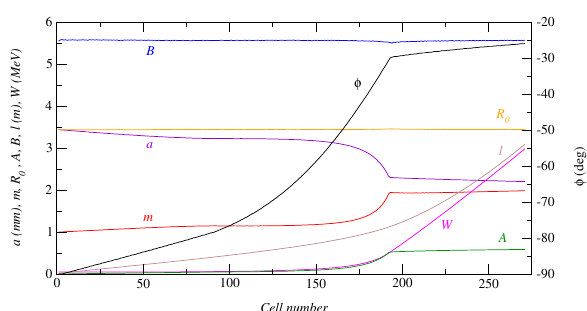
Figure 2. Evolution of several modulation parameters as a func- tion of the cell